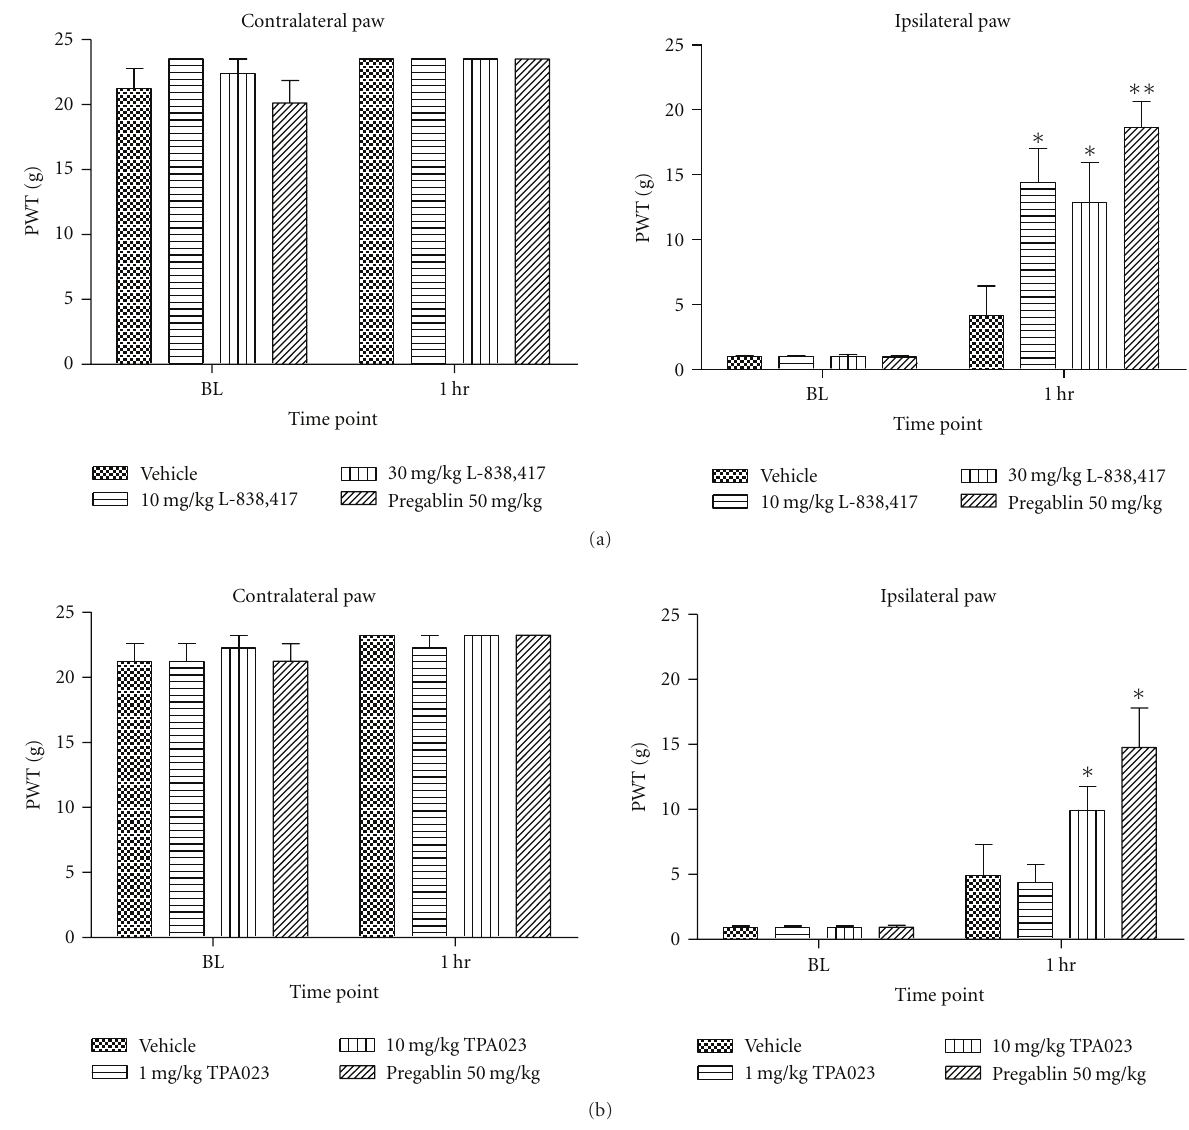
Figure 5: The e ff ects of (a) L-838,417 and (b) TPA023 on spinal nerve ligation-induced static allodynia in the rat. Data are means ± sem. n = 10. Data are expressed as paw withdrawal threshold (PWT). BL: baseline. ( ∗ = P < 0 . 05, ∗∗ = P < 0 . 01 compared to vehicle-treated group. Mann-Whitney nonparametric